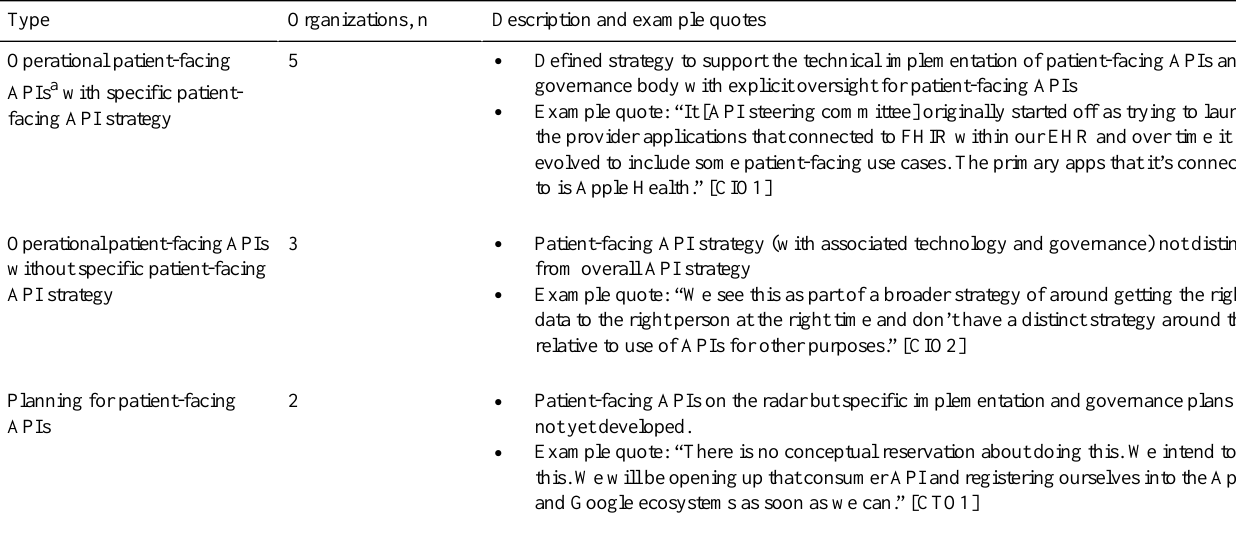
Description and example quotesOrganizations,